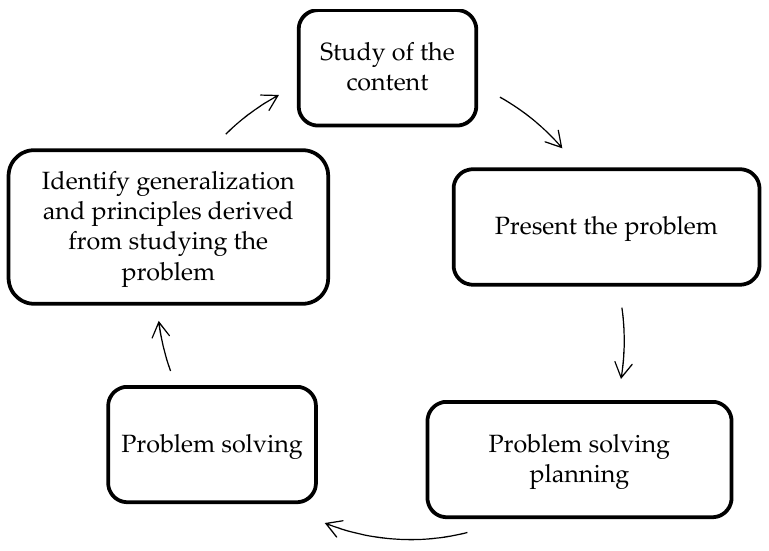
Figure 5. Adapted process of problem-based learning.